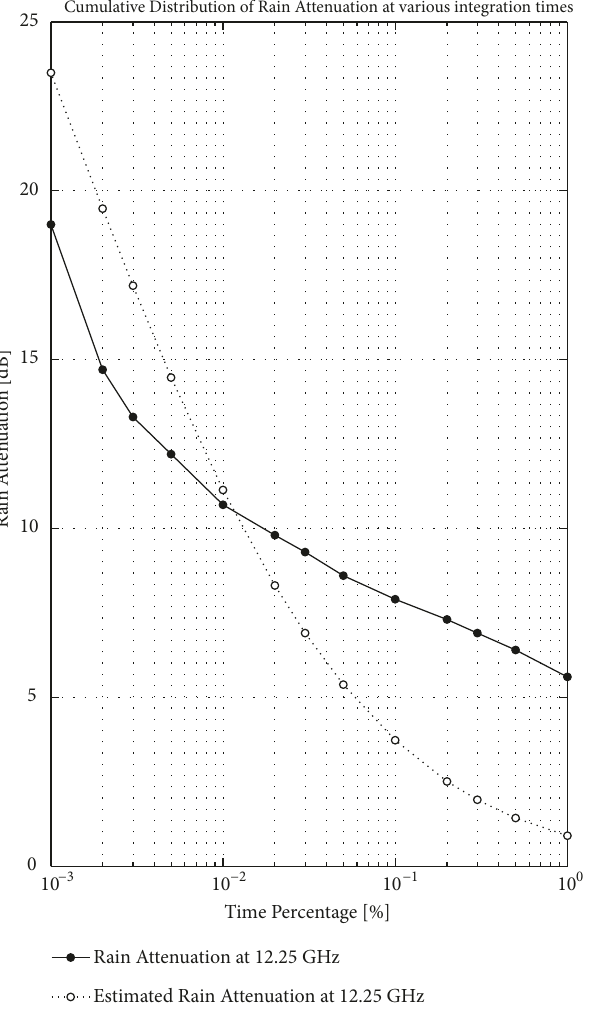
Figure 5: Rain attenuation versus rain rate